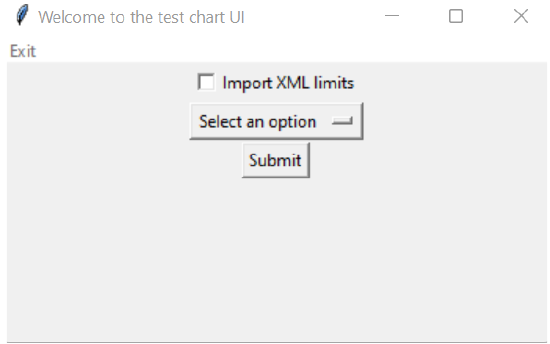
Figure 6. Graphical user interface